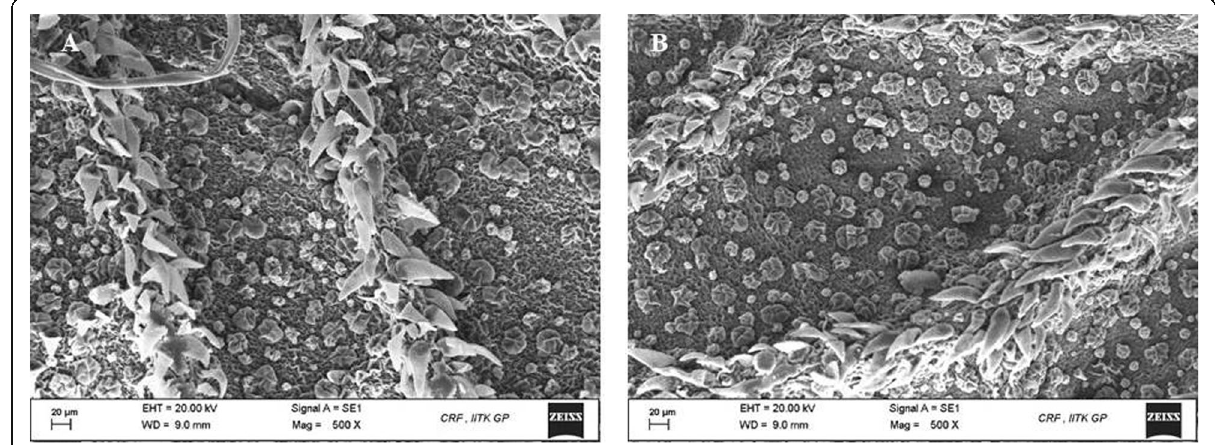
Fig. 3 Scanning electron micrograph of the M. hortensis leaf surface after air drying ( a ) without OsO 4 , and ( b ) with OsO 4 . Imaged at 20.00 kV with a magnification of X500. Scale bar represents 20 μ